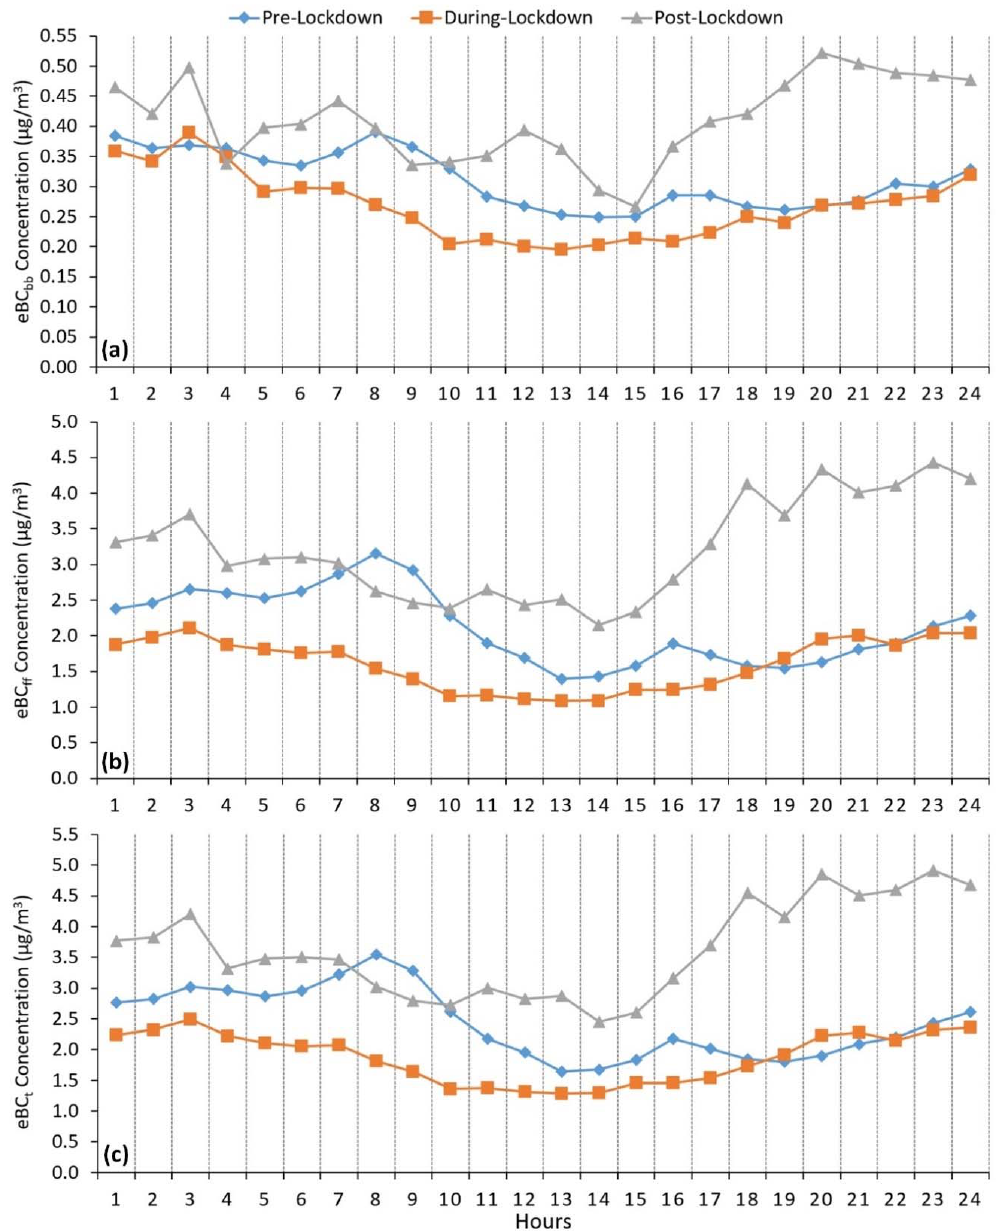
Figure 3. Hourly variations of equivalent black carbon (eBC) concentrations along Pre ‐ LD, LD, and Figure 3. Hourlyvariationsofequivalentblackcarbon(eBC)concentrationsalongPre-LD,LD,andPost-LD Post ‐ LD phases: ( a ) eBC bb , ( b ) eBC ff , and ( c ) eBC t . phases: ( a ) eBC bb , ( b ) eBC ff , and ( c ) eBC t